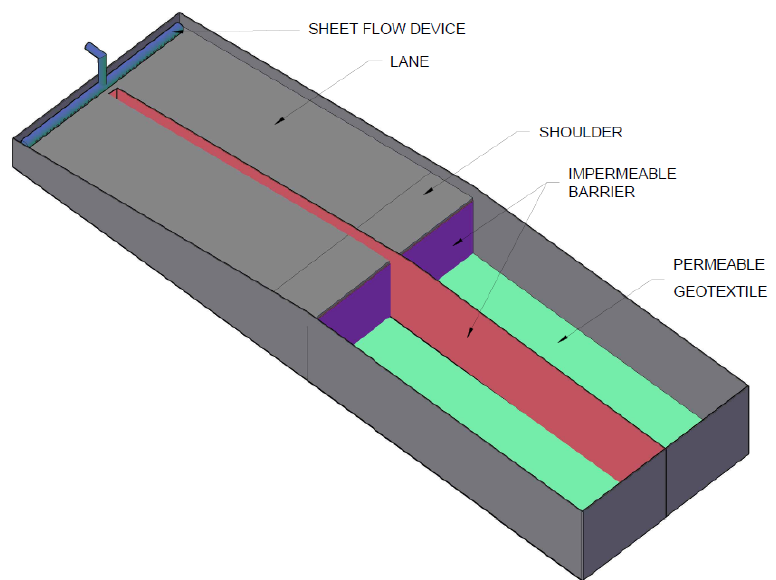
Figure 1. Diagram of empty test bed.